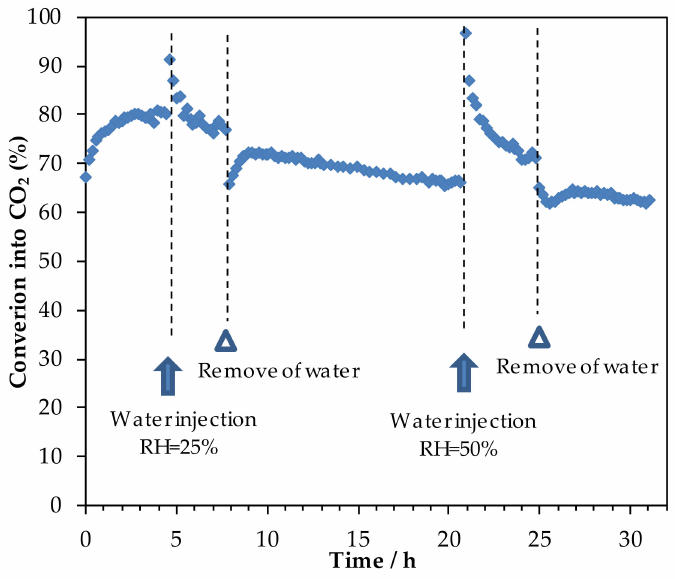
Figure 12. E ff ect of H 2 O on HCHO conversion over the Mn10Hap catalyst: 135 ◦ C, HCHO = 110 ppm in moist air, RH = 25% and 50%, VHSV = 500 mL g cat − 1 h − 1 . Regeneration Step of the Catalyst